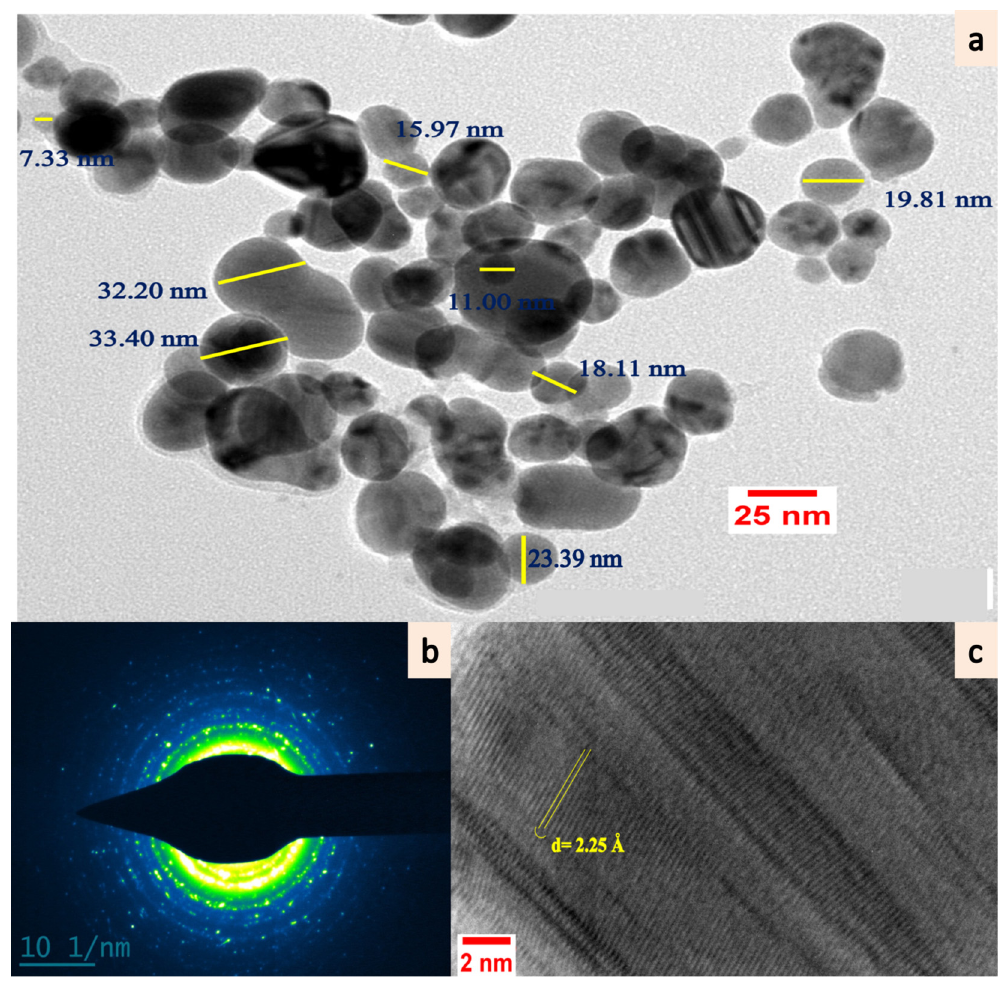
Figure 4. HRTEM micrographs of ( a ) synthesized ELAgNPs, ( b ) SAED pattern of crystalline ELAgNPs, and ( c ) single spherical ELAgNP with d-spacing.